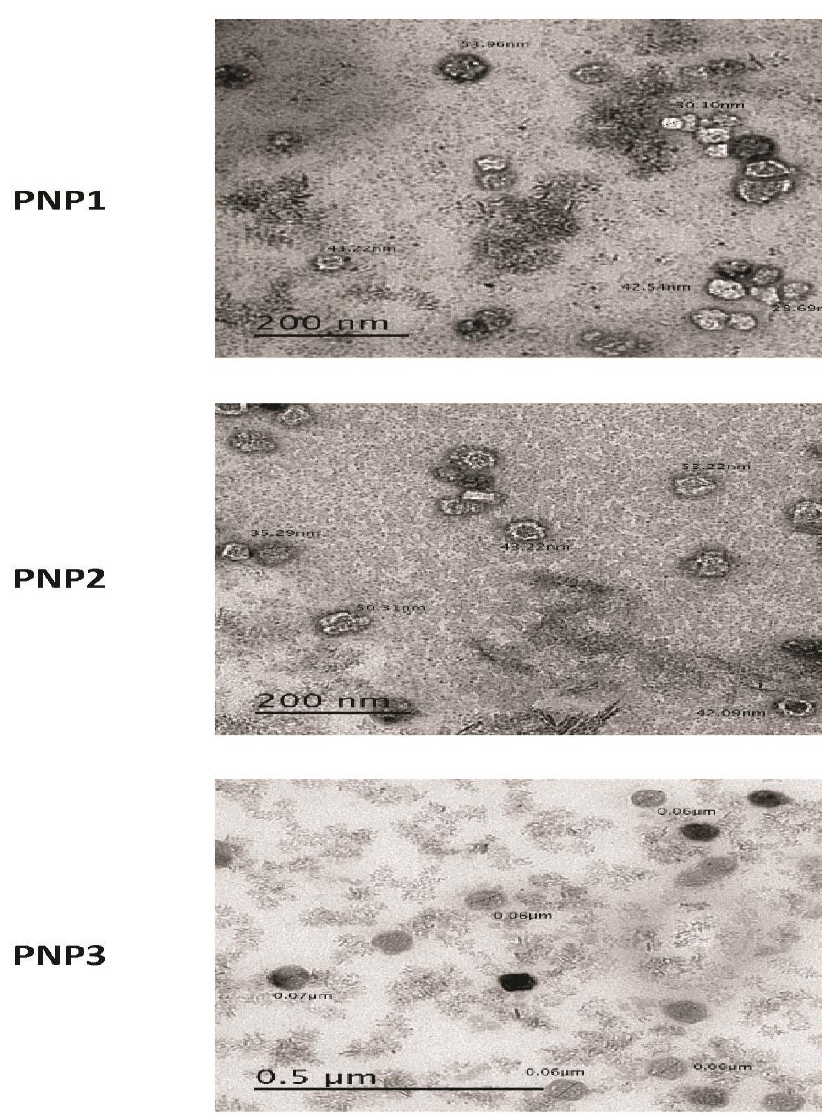
Figure 3. Transmission electron microscope photographs of prepared DOXY–PNPs.